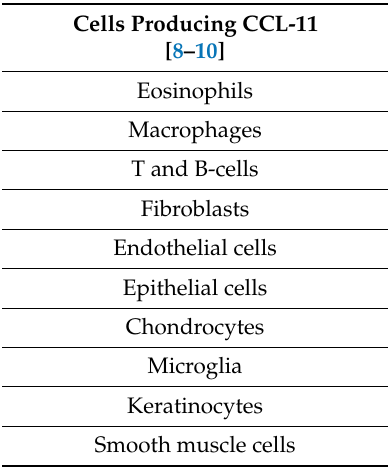
Table 1. Cells producing CCL-11.